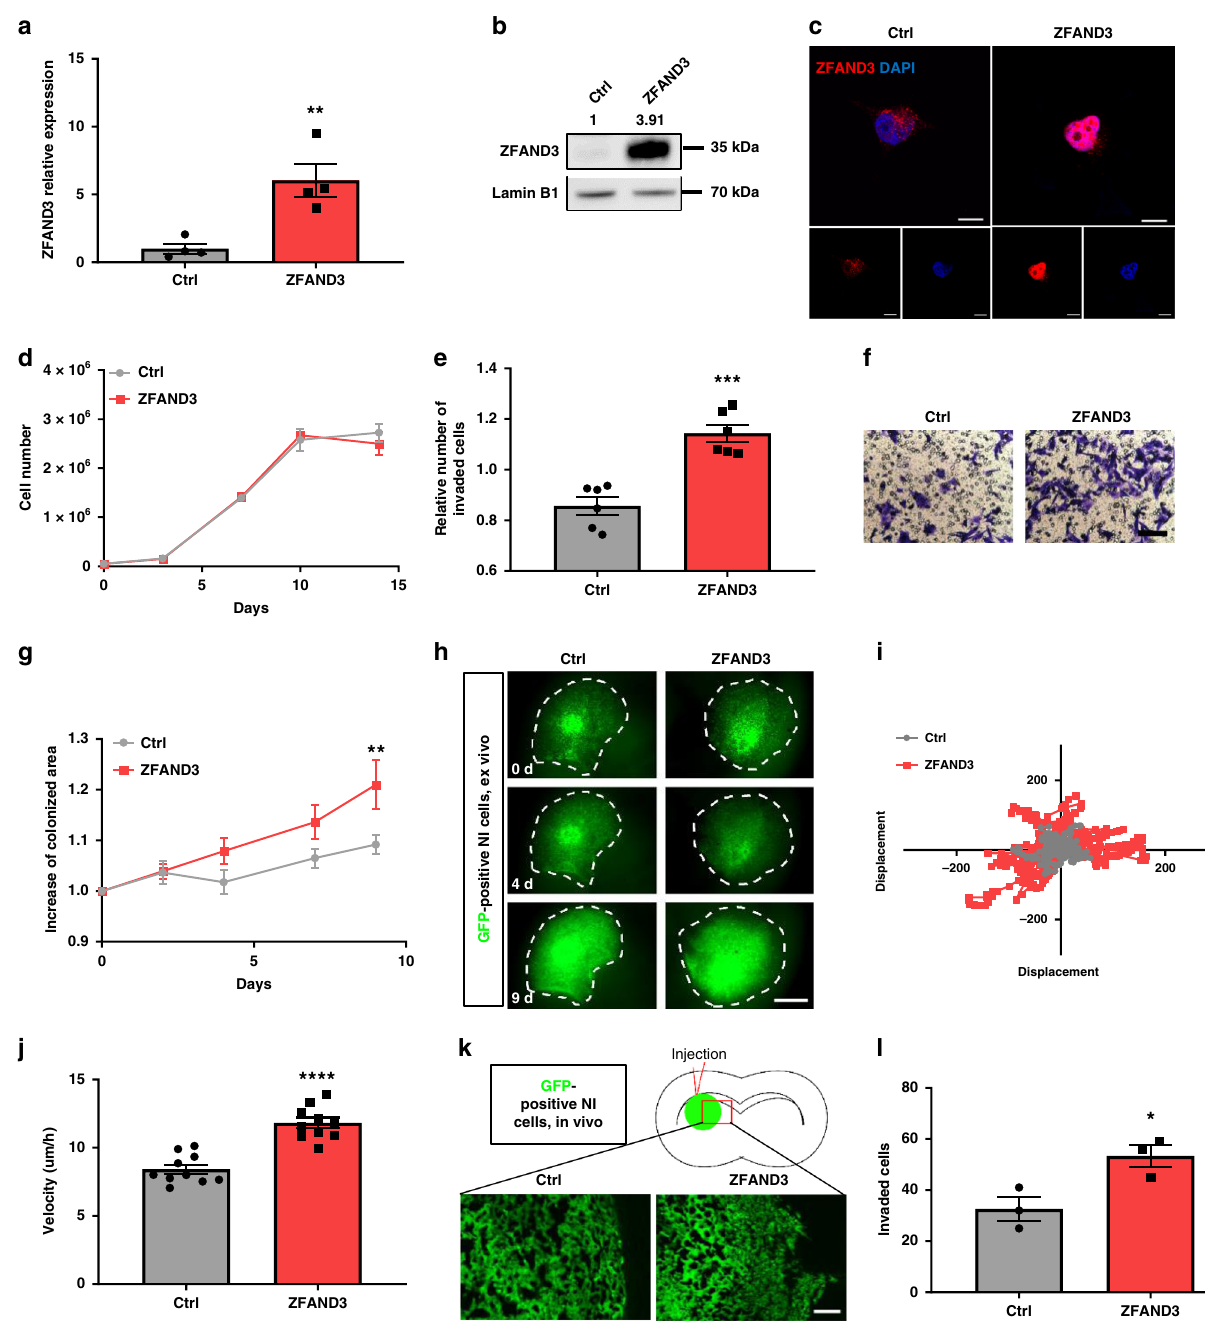
Fig. 4 Overexpression of ZFAND3 in non-invasive GBM cells confers invasion potential. ZFAND3 overexpression in non-invasive GSCs (NI) ( n = 4 biologically independent samples) con fi rmed by qPCR ( a ), Western blot ( n = 3) ( b ) and with IF staining ( c ) (red: ZFAND3, blue: DAPI. Scale bars = 10 µ m). d ZFAND3-overexpression did not affect cell proliferation (n = 3 biologically independent experiments). e , f Boyden chamber invasion assay indicating increased invasion potential in ZFAND3-overexpressing cells ( n = 6 biologically independent experiments) (Scale bar = 100 µ m). g , h ZFAND3- overexpressing cells implanted in ex vivo brain slice cultures showed augmented colonization compared to control cells, 9 days after tumor implantation ( n = 10 biologically independent samples) (Scale bar = 1000 µ m). i Velocity of ZFAND3-overexpressing cells in ex vivo brain slice cultures was improved compared to control cells ( n = 10, p < 0.0001). j Visualization of single cell displacement for control and ZFAND3-overexpressing cells in ex vivo brain slice cultures ( n = 15 cells over 10 biologically independent samples). k , l Upon orthotopic xenografting in mice ( n = 3), an increased number of ZFAND3- overexpressing cells invaded out of the tumor border into the surrounding tissue, compared to control cells (analysis done at 4 weeks after implantation) (3 sections per mouse) (Scale bar = 100 µ m). Results of ( a , e , g , j , l ) are displayed as average ± SEM, results of ( a , e , j , and l ) were analysed with an unpaired, two-sided t test, results of g were analysed with a two-way ANOVA. * p value < 0.05, ** p value < 0.01, *** p value < 0.001, **** p value <